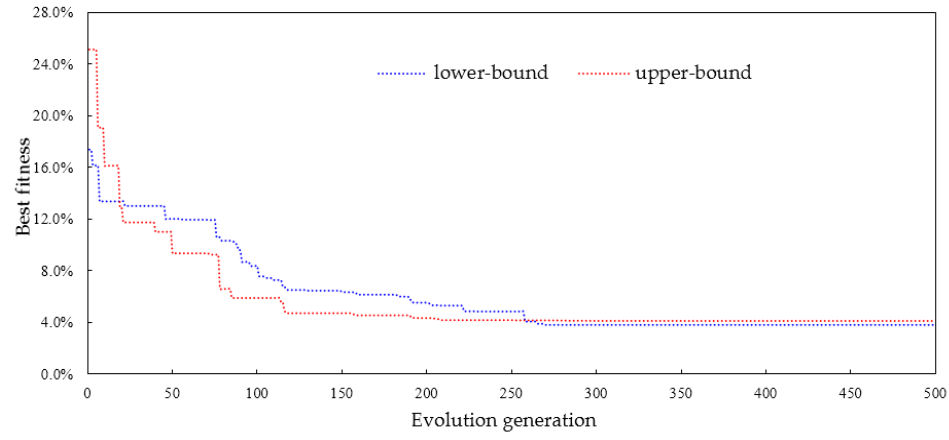
Figure 7. The evolution process of best fitness when calculating upper- and lower-bound forecasting values.